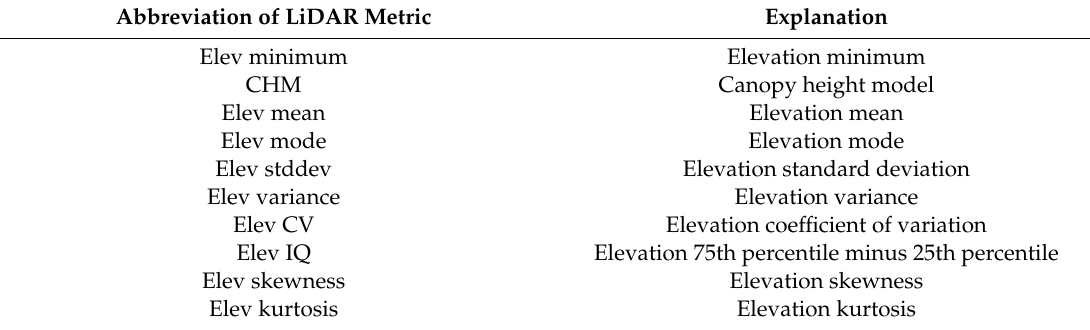
Table A1. LiDAR elevation metrics derived LiDAR